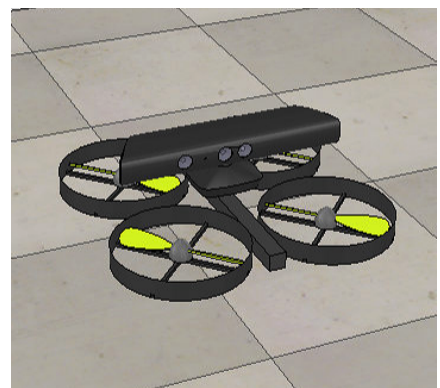
Figure 9. UAV in